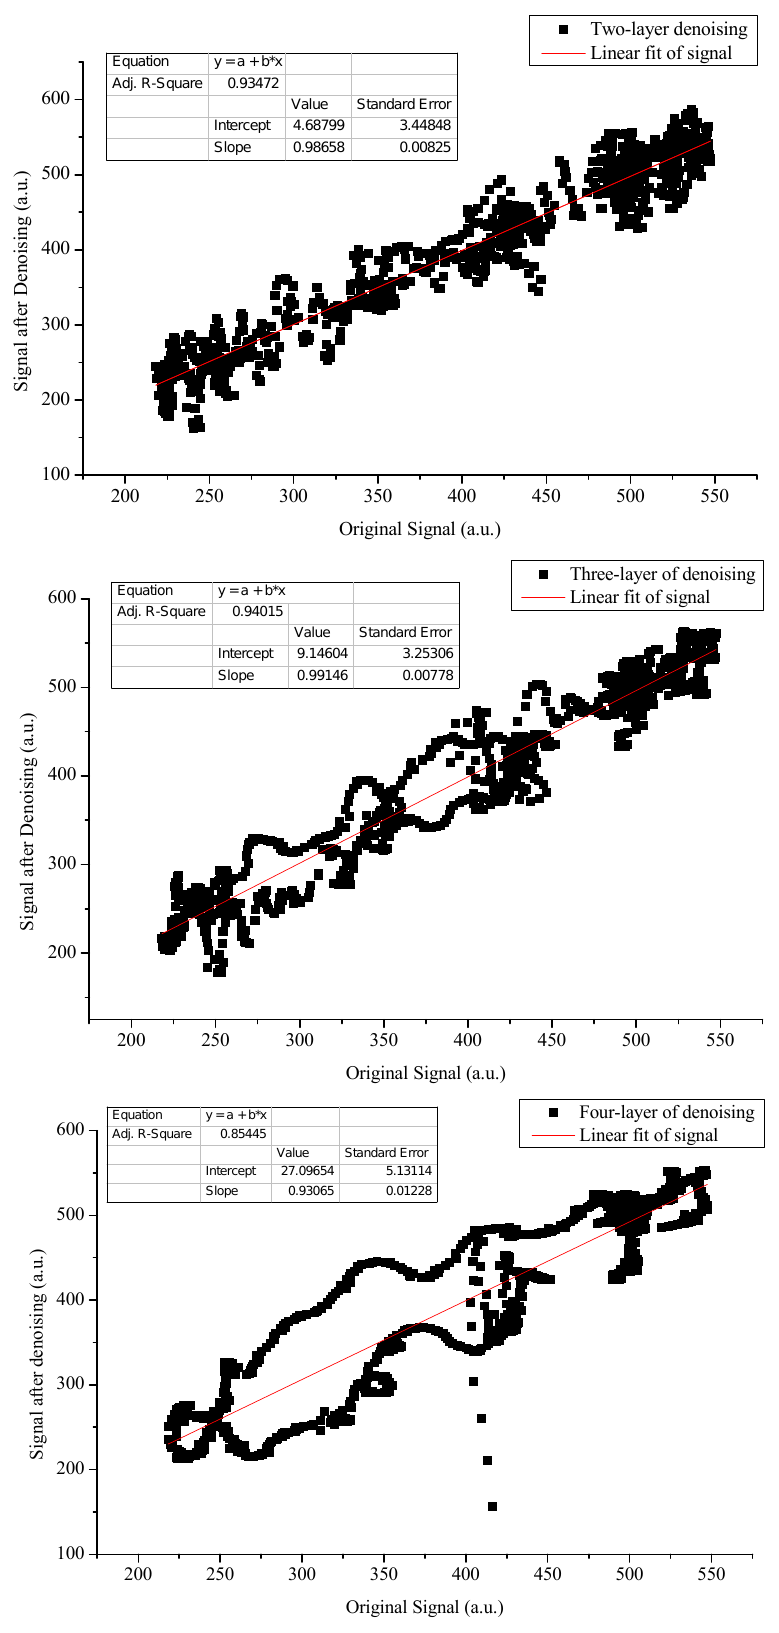
Figure 13. Denoising effect of db5 LWT under different decomposition scales (the decomposition scales are one to four layers in turn).